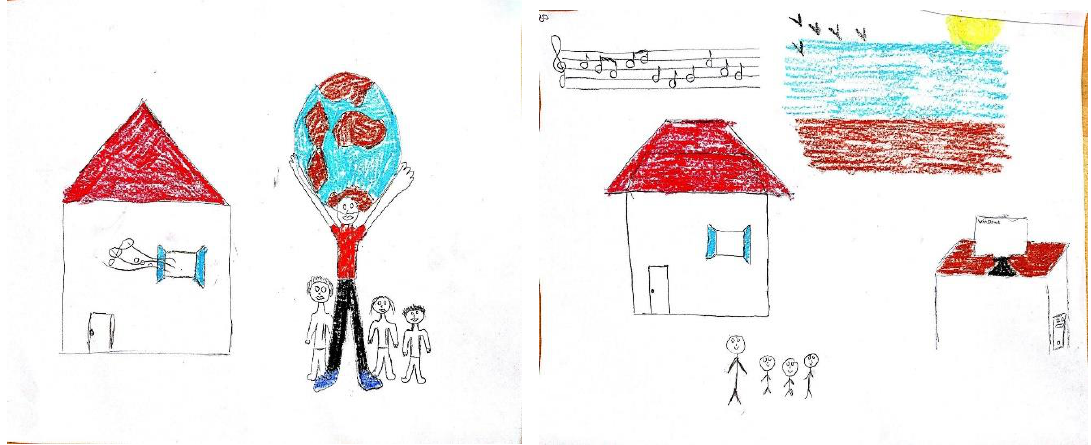
Figure 2. Selecting the stress drawing as the format for the integrative drawing.